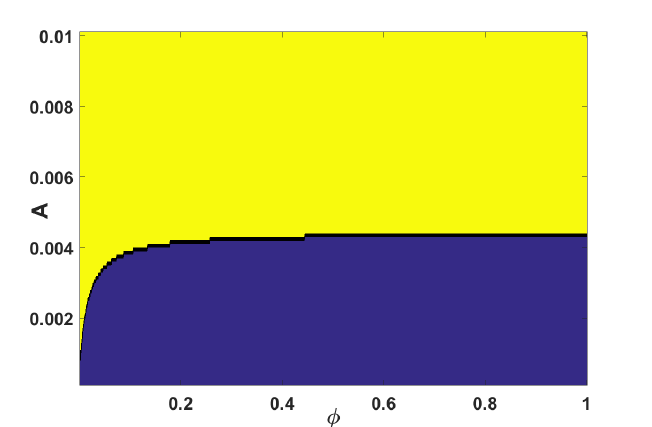
Figure 3. The yellow area corresponds to R 0 > 1, while the blue area is R 0 < 1 of model (3a–e)–(5) with the same initial conditions and parameters as those in Figure